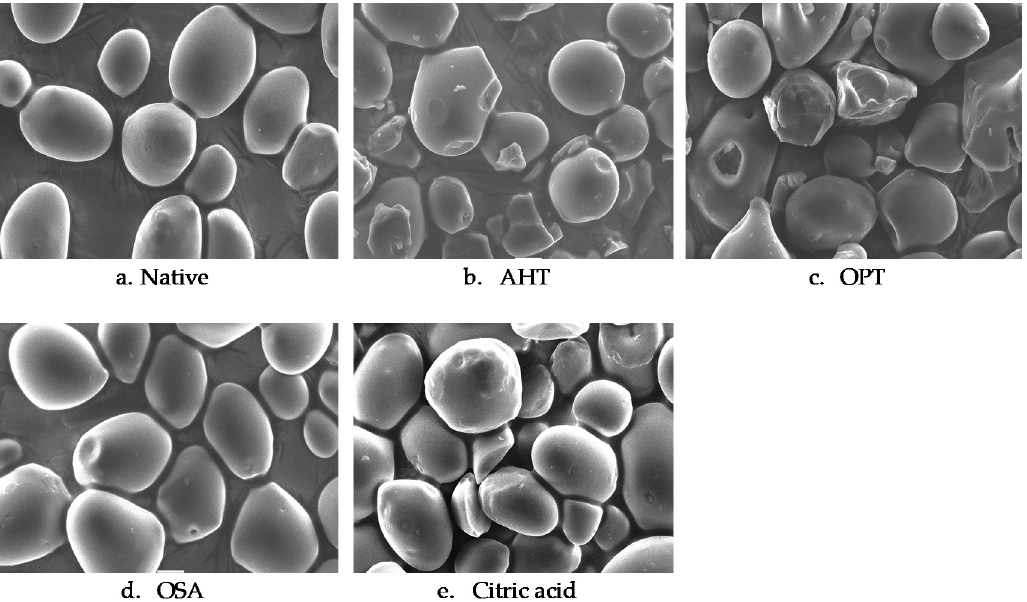
Figure 1. Granule morphology of native and various modified sago starches (1000 × ). AHT = autoclave-heating treatment, OPT = osmotic-pressure treatment, OSA = octenyl-succinic anhydride, CA = citric acid cross-linking .